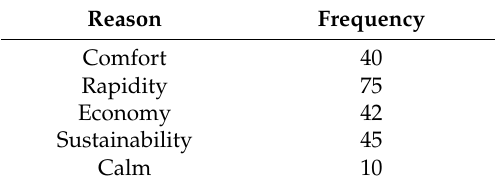
Table 10. Absolute frequency of reasons for changing means of transport (Q19.2).